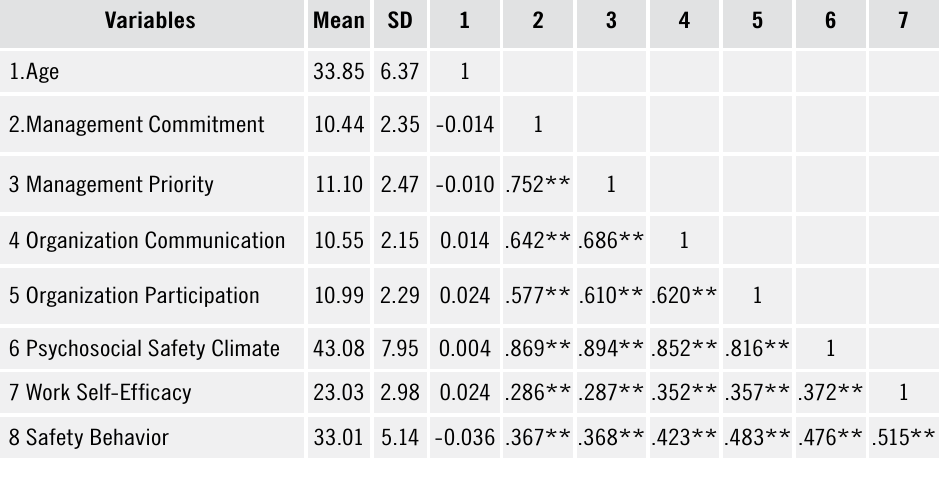
Table 1. Mean, standard deviation, and correlation matrix of the variables in the study